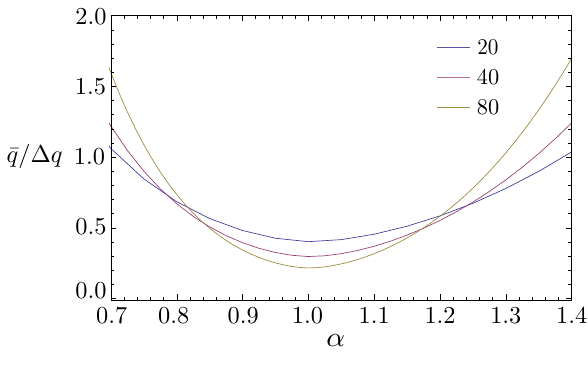
Figure 8: Characterizing the distribution of unpaired spins, q , left behind after emission. The ratio of the mean to the variance as a function of imbalance ( α ), for three different system sizes ( M